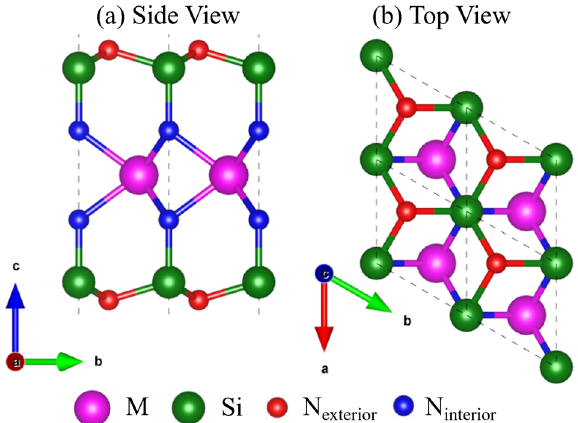
Fig. 1 Side view and top view of the crystal structure of monolayer MoSi 2 N 4 . The surface and interior N atoms are shown with red and blue colors, respectively.